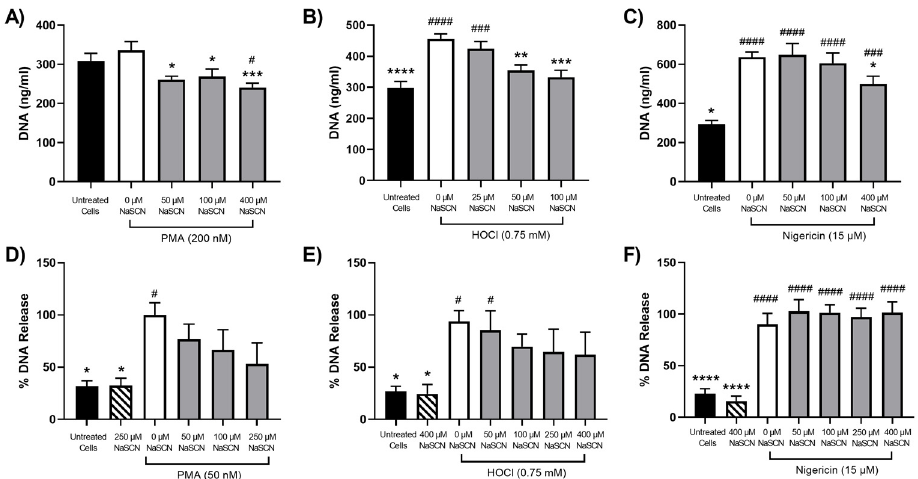
Figure 4. Effect of SCN − on NET release from neutrophils stimulated with PMA, HOCl or nigericin. Panels ( A – C ): Differentiated PLB-985 cells (1 × 10 6 cells) were incubated with SCN − (25–400 µ M) for 15 min at 37 ◦ C prior to the addition of ( A ) PMA (200 nM), ( B ) HOCl (0.75 mM) or ( C ) nigericin (15 µ M) for 4 h at 37 ◦ C. Panels ( D – F ): Primary neutrophils (1 × 10 6 cells) were incubated with SCN − (50–400 µ M) for 15 min at 37 ◦ C prior to the addition of ( D ) PMA (50 nM), ( E ) HOCl (0.75 mM) or ( F ) nigericin (15 µ M) for 3 h at 37 ◦ C. Following treatment, NETs were released by the addition of DNase (40 U) for 15 min and quantification of extracellular DNA using a Quant-iT TM PicoGreen TM dsDNA assay kit. Data are presented as mean ± S.E.M. from at least 3 experiments. *, **, *** and **** indicate a significant ( p < 0.05, 0.01, 0.001, 0.0001) change compared to PMA-, HOCl- or nigericin-stimulated cells in the absence of SCN − (white bars), while #, ##, ###, and #### indicate a significant ( p < 0.05, 0.01, 0.001, 0.0001) change compared to untreated cells (black bars) as determined by one-way ANOVA with Dunnett’s multiple comparisons post hoc test.